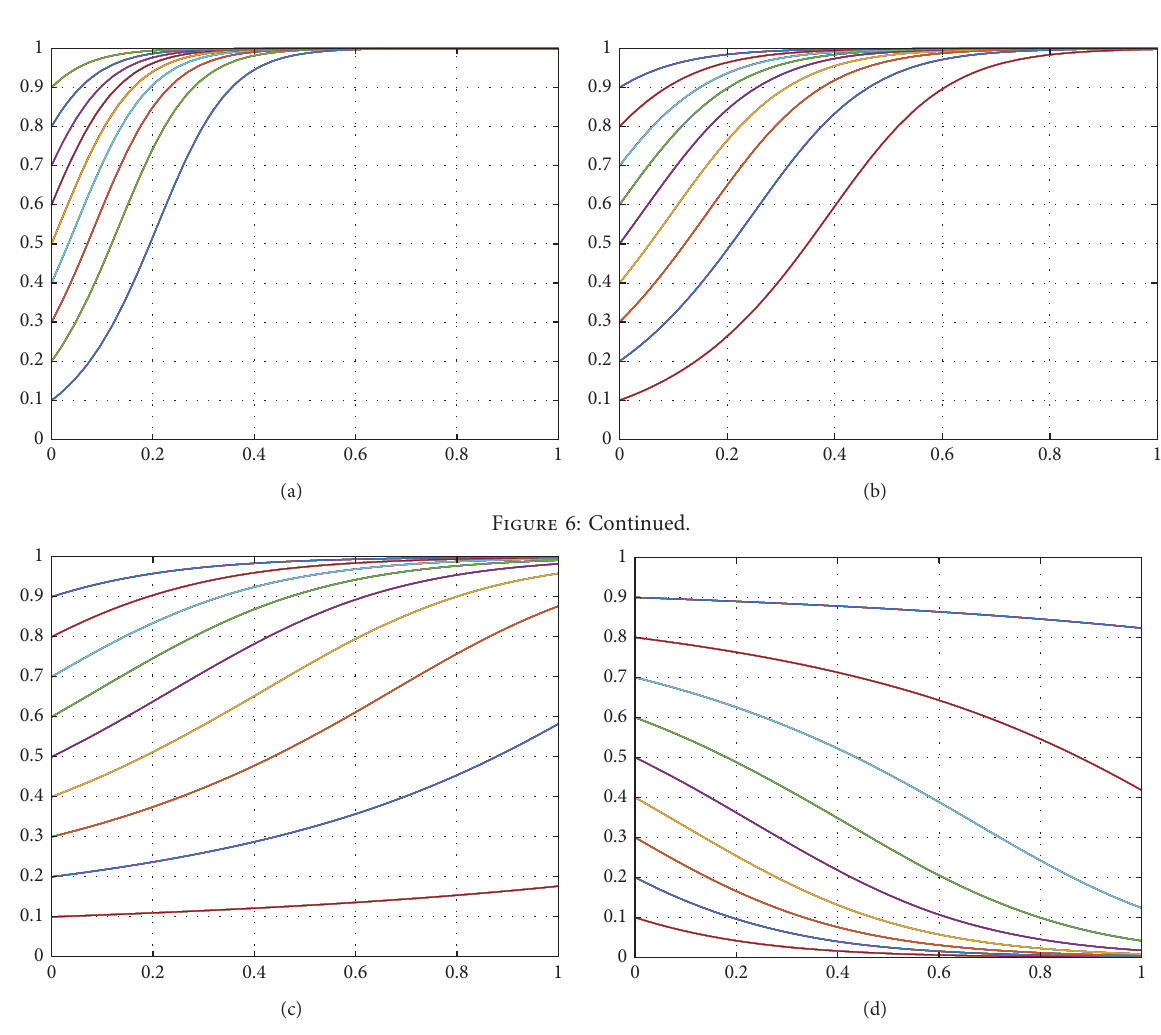
Figure 6: In the case of different θ values, dynamic evolution process of information sharing: (a) θ � θ � (d) θ 1 2